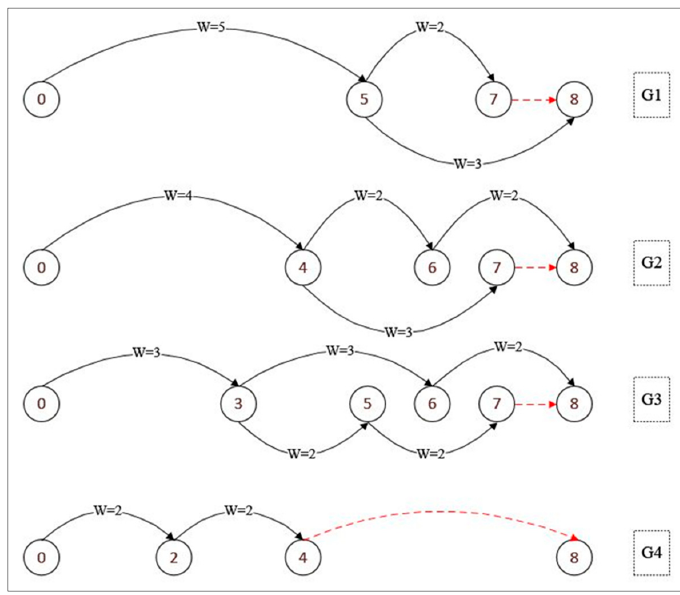
Figure 4. Graphs corresponding to Example 2.